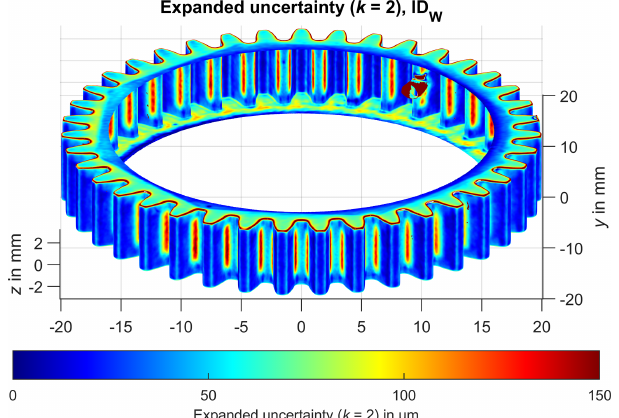
Figure 6. Visualization of the expanded measurement uncertainty ( k = 2) of gear wheel ID W .